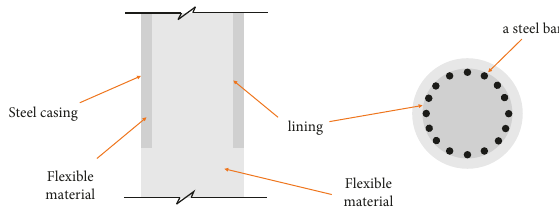
Figure 14: Schematic diagram of antislide piles with the flexible